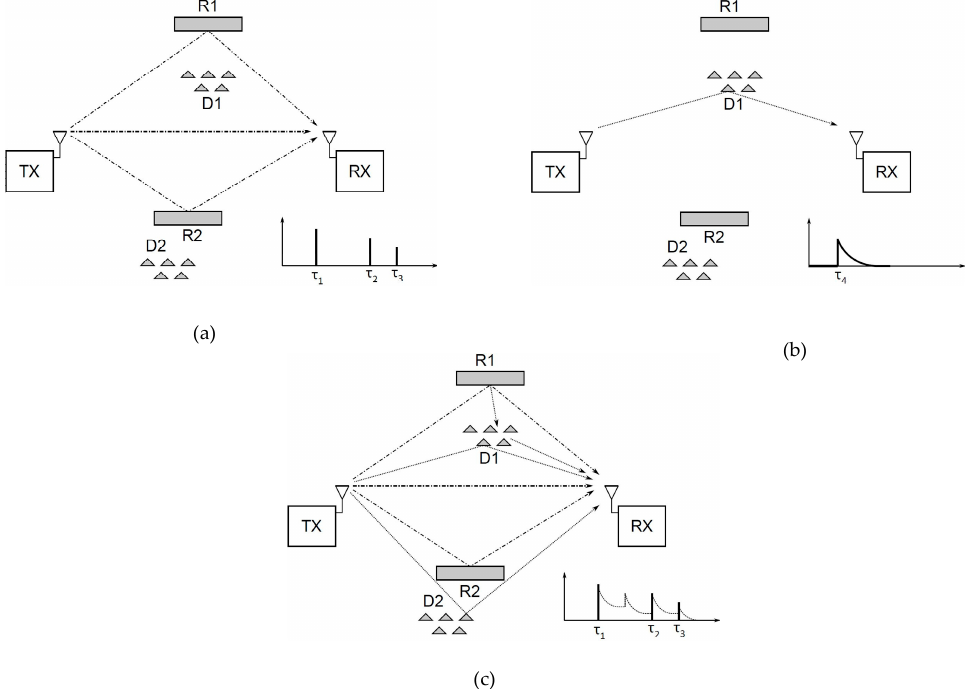
Figure 3. Multiple signal propagation in conditions of multiple reflections and scattering: ( a ) direct and specular reflective multipath components (MPC) components, ( b ) single MPC component generated by scattering, ( c ) overall MPC signal components on the receiver (RX); Tx—transmitter, R1, R2—reflectors, D1, D2—diffusors, τ —time.